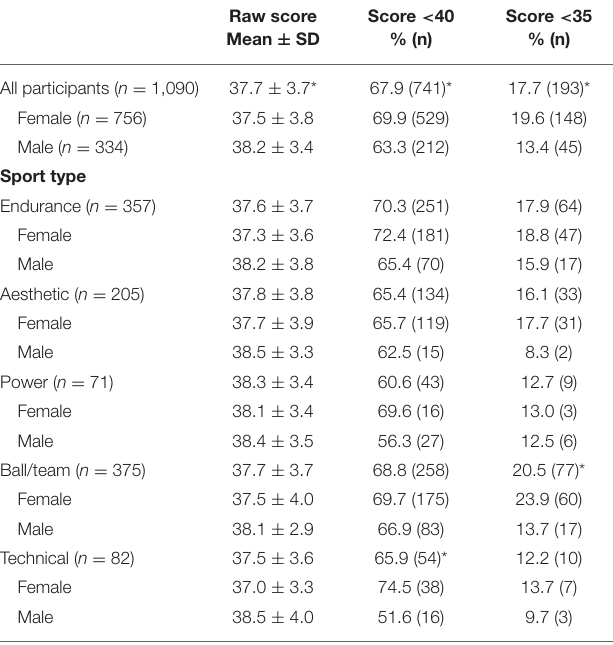
Raw score Score < 40 Score < 35 Mean ± SD % (n) % (n)